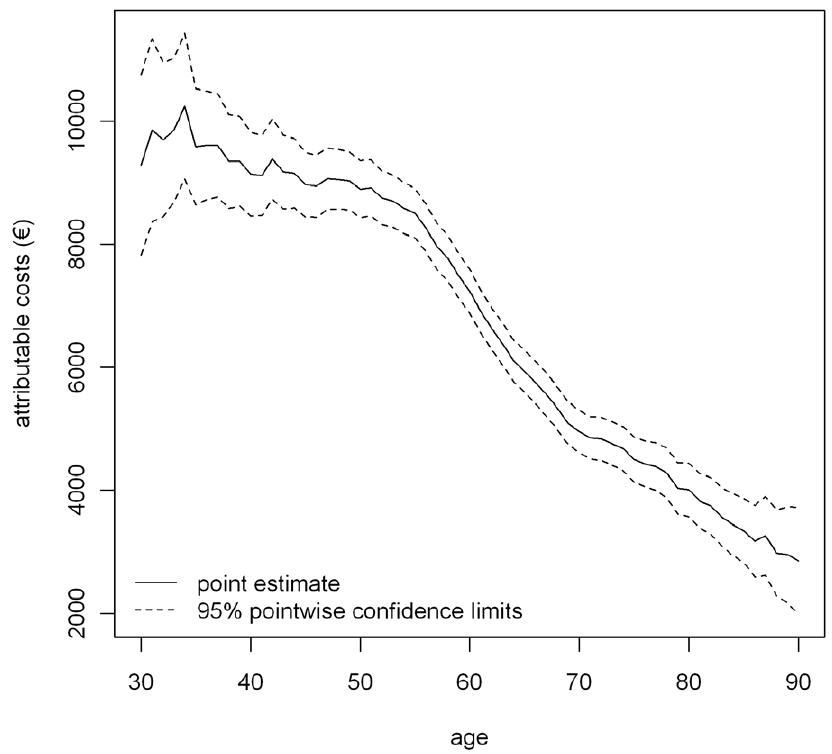
Figure 2. Breast cancer attributable costs (in 2010 euros).